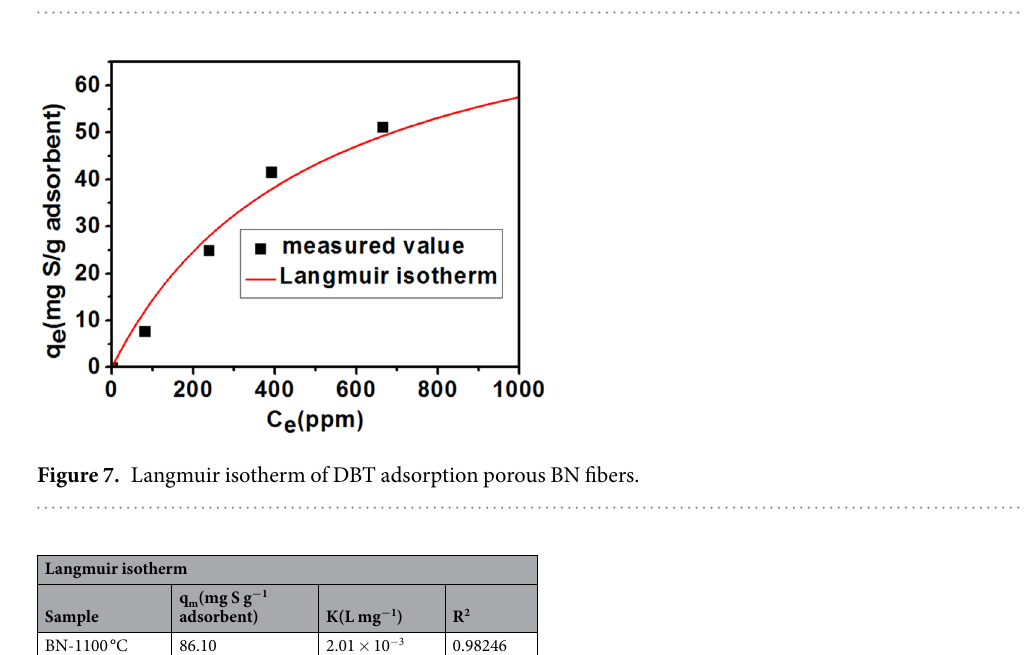
Figure 6. The adsorption capacity of porous BN microfibers prepared at different calcination temperatures.